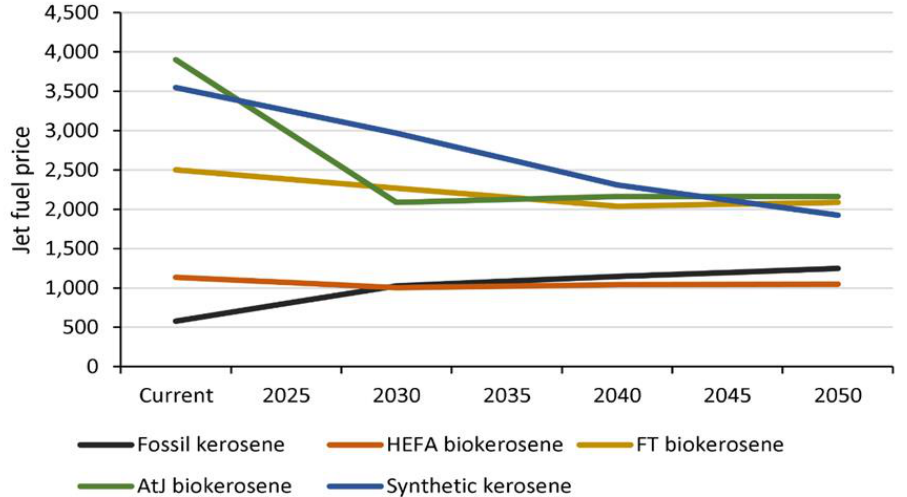
Figure 1. Global average prices of fuels used in aviation (in Eur/tonne).